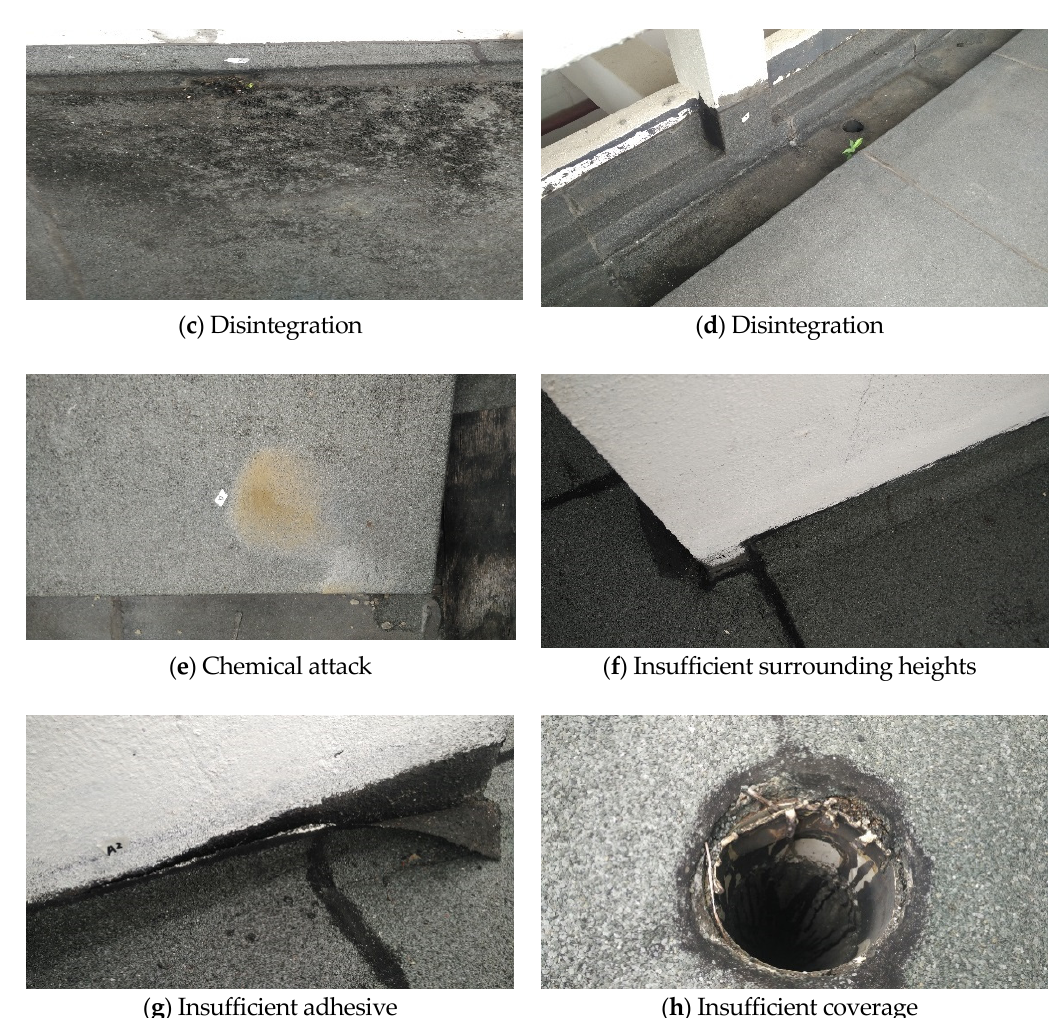
Figure 10. Defects identified in remedial treatment.